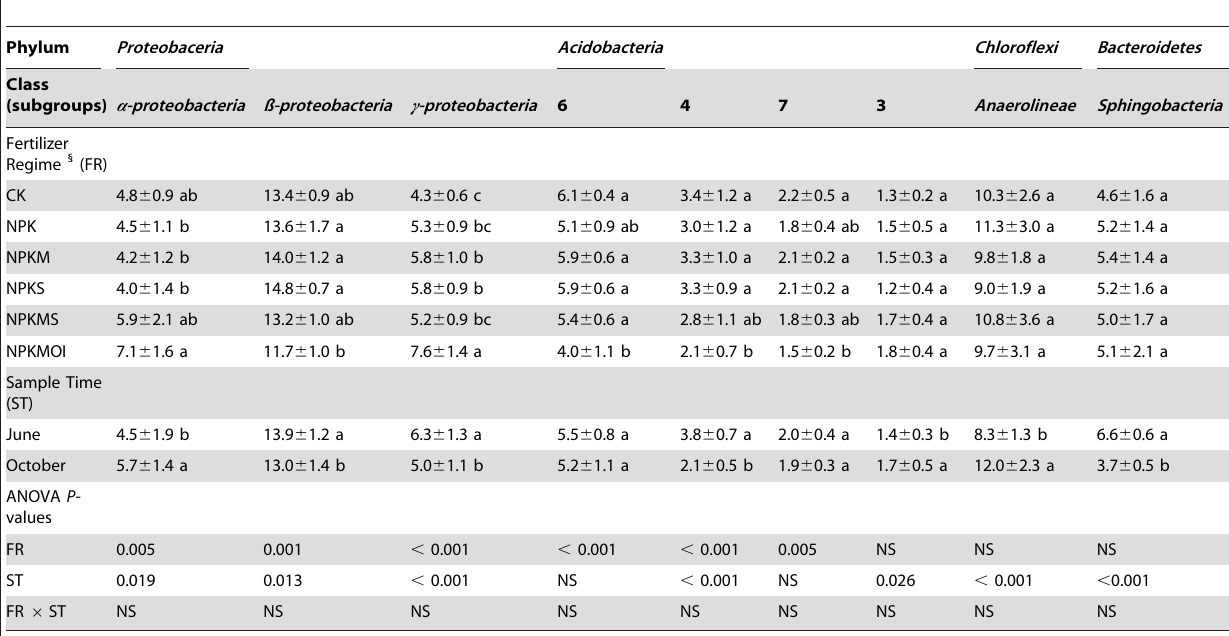
Table 3. Effect of fertilizer regime, sample time and the interaction between them on the relative abundance (%) of abundant bacterial classes (subgroups) £ (relative abundance .